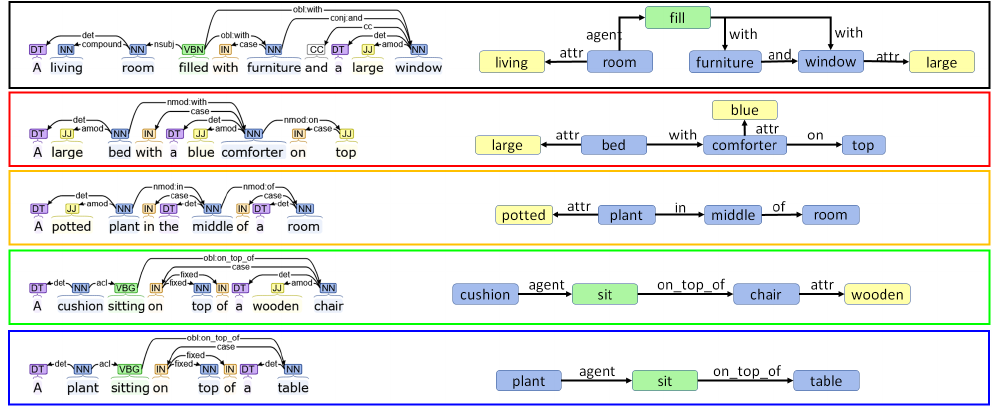
Figure 4. Generating graphs for the generated captions as shown in Figure 3. Left : depen- dency parse tree generated using Stanford dependency parser. Right : generated Graph using the proposed